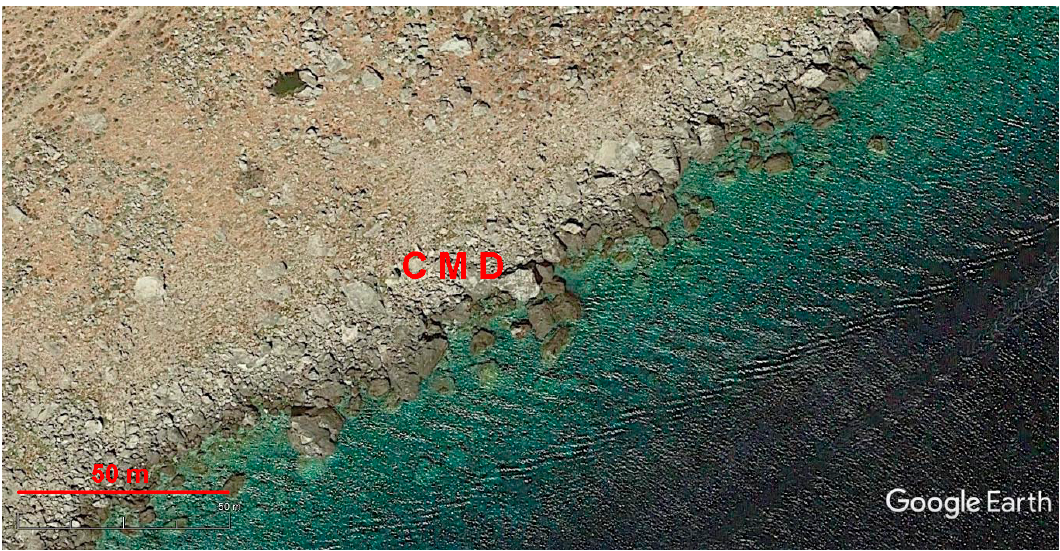
Figure 4. The southern plot of the Ponza Island locality (the view provided by the Google Earth Engine).